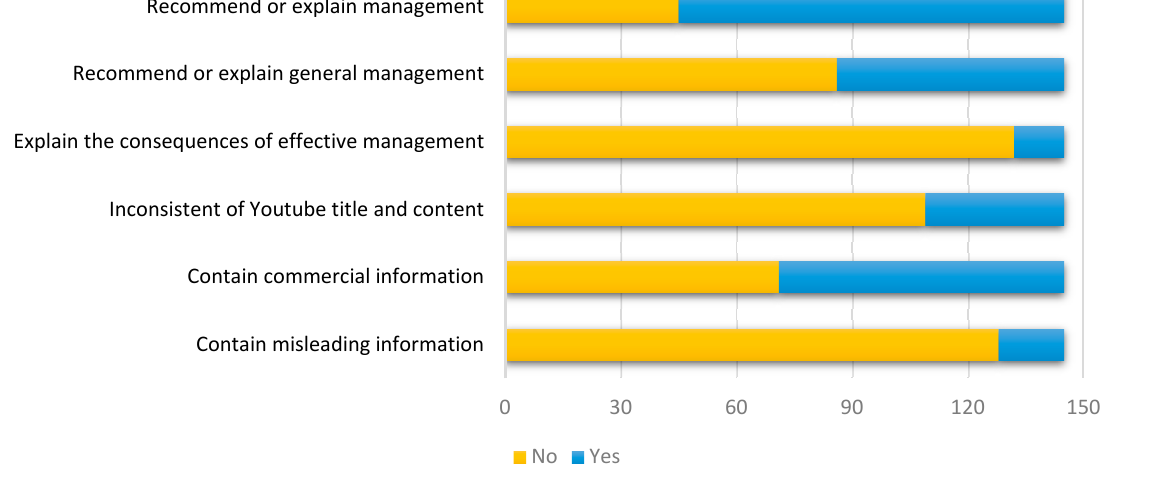
Figure 7. Features of the video content.